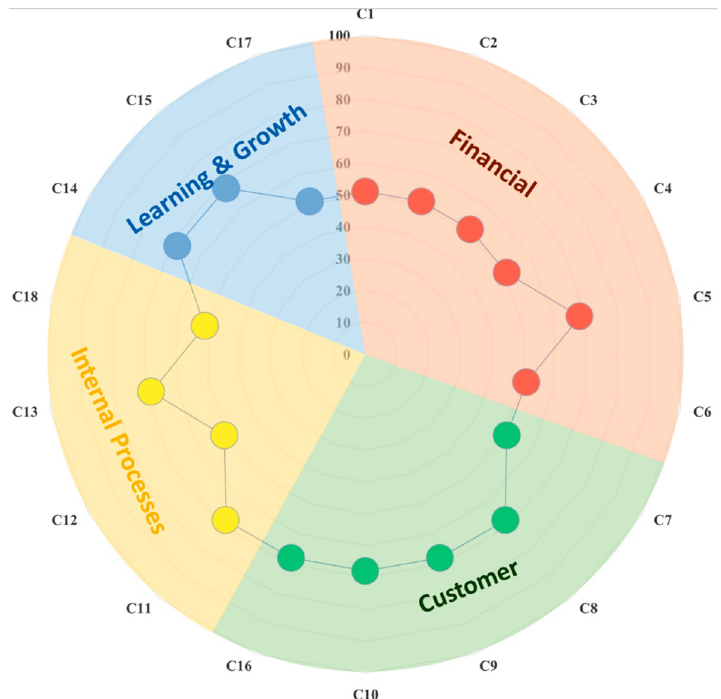
Figure 4. Radar chart for hospital performance in terms of model